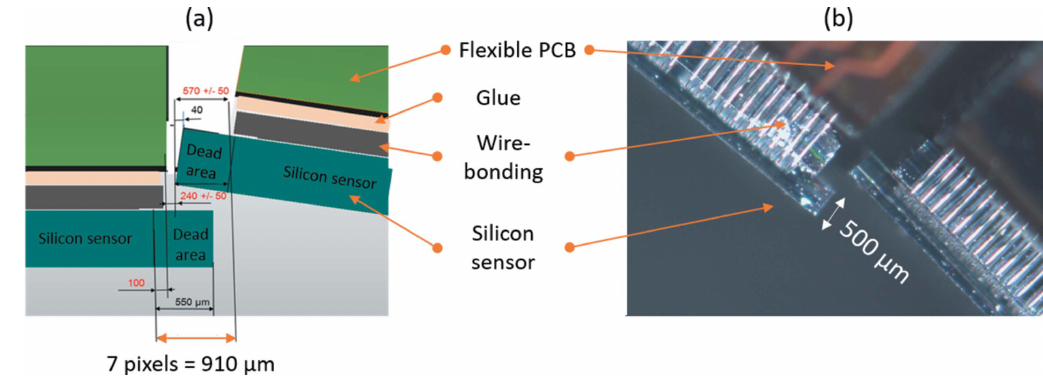
Figure 5 The overlap of two XPAD-S70 modules, showing ( a ) a schematic view and ( b ) a photograph of two consecutive